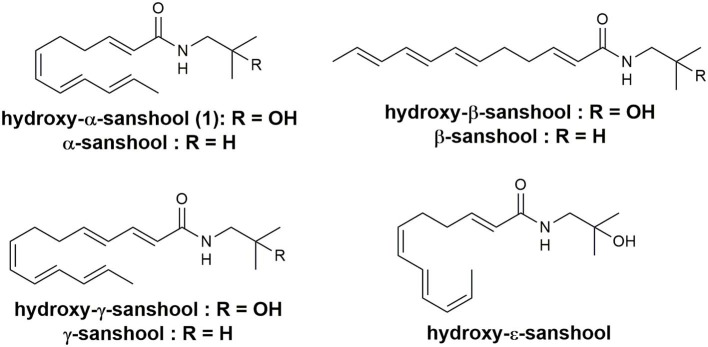
Sanshool compounds.